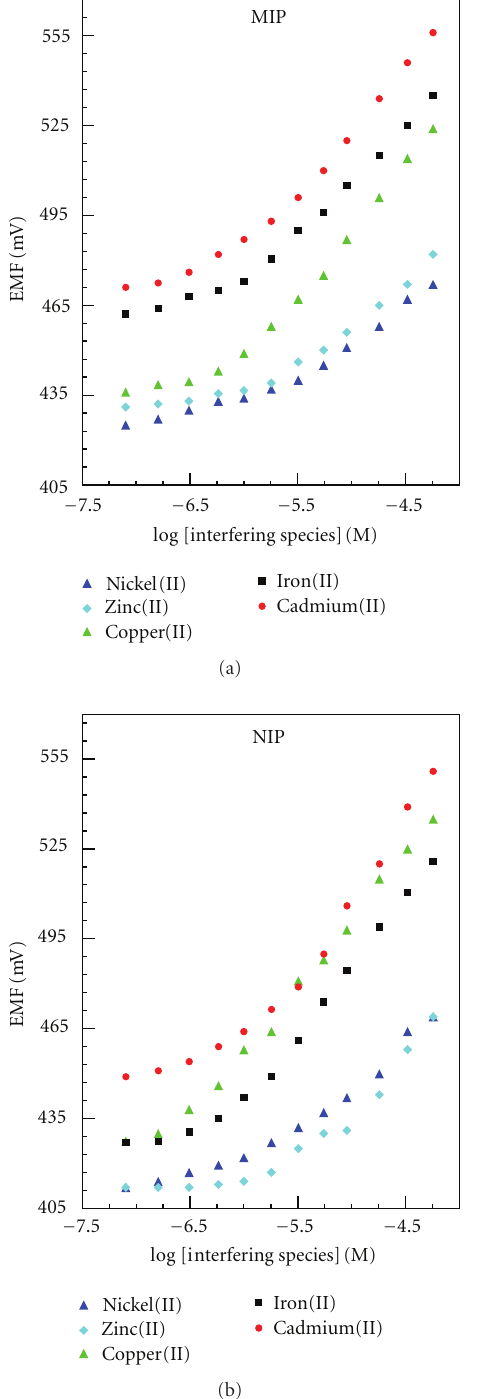
Figure 4: The response behavior of the proposed sensors towards di ff erent metal ion